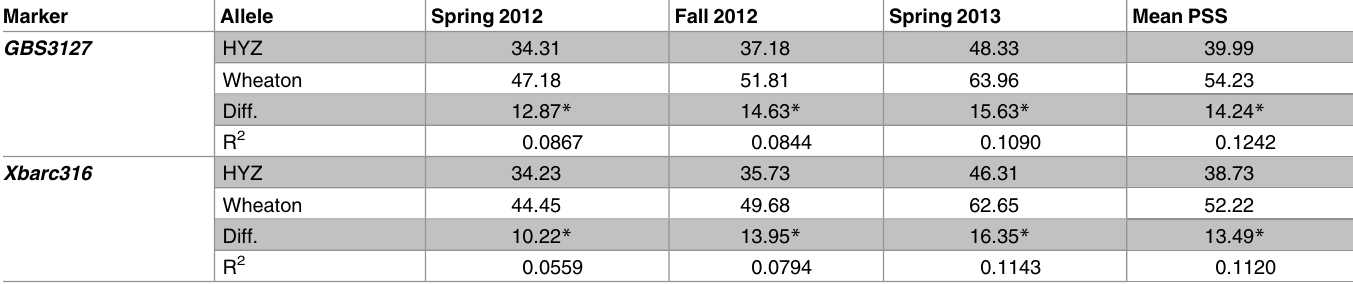
Table 2. Difference in FHB severity between FHB resistance (R) and susceptibility (S) alleles at the QTL on chromosome 5A as reflected by two closely linked markers,and coefficients of determination of the QTL estimated from HYZ x Wheaton RILs tested in spring and fall 2012 and spring 2013 greenhouse experiments. Marker